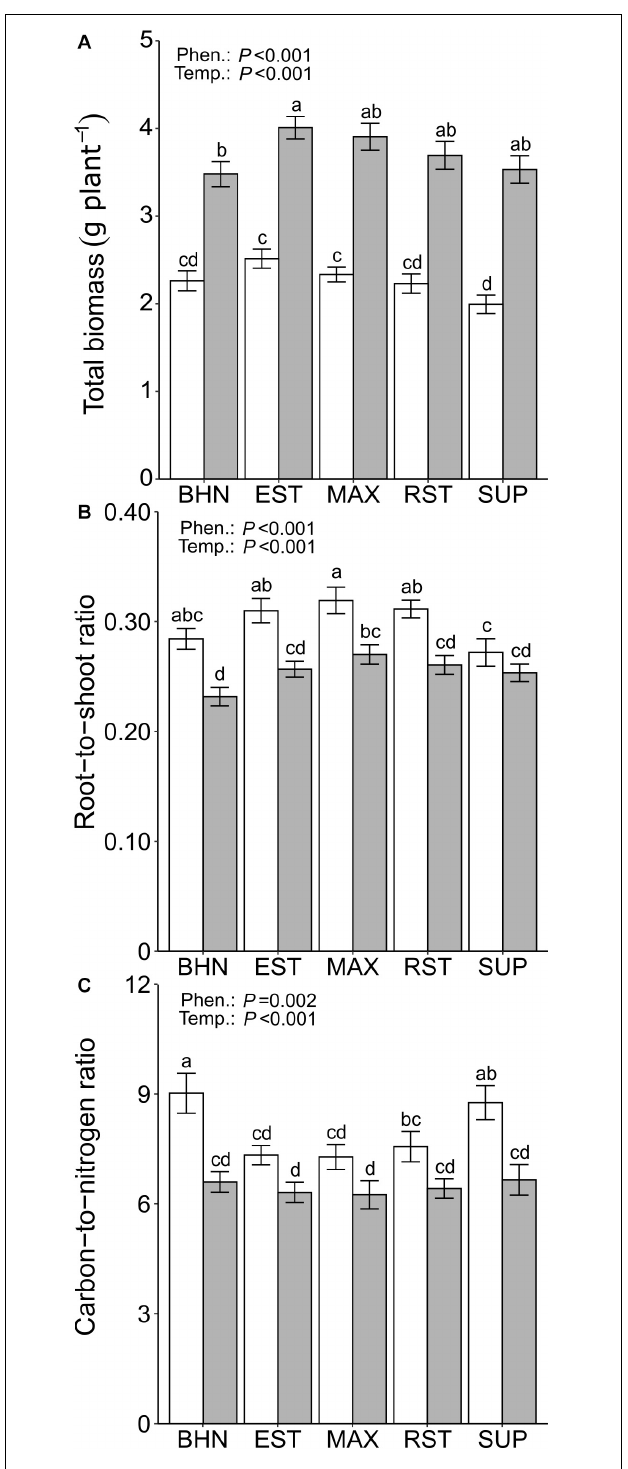
FIGURE 4 | Total biomass (root + shoot; A ), root-to-shoot ratio (B) , and C-to-N ratio (C) of four grafted rootstocks (Estamino, Maxifort, RST-04-106-T, and Supernatural) and one cultivar (BHN-589) grown under optimal (gray) and suboptimal (white) soil temperatures for 4 weeks. All rootstocks were grafted with BHN-589. Values are mean ± standard error ( A,B : n = 45–50; C: n = 10). Means followed by different letters are statistically different at P <